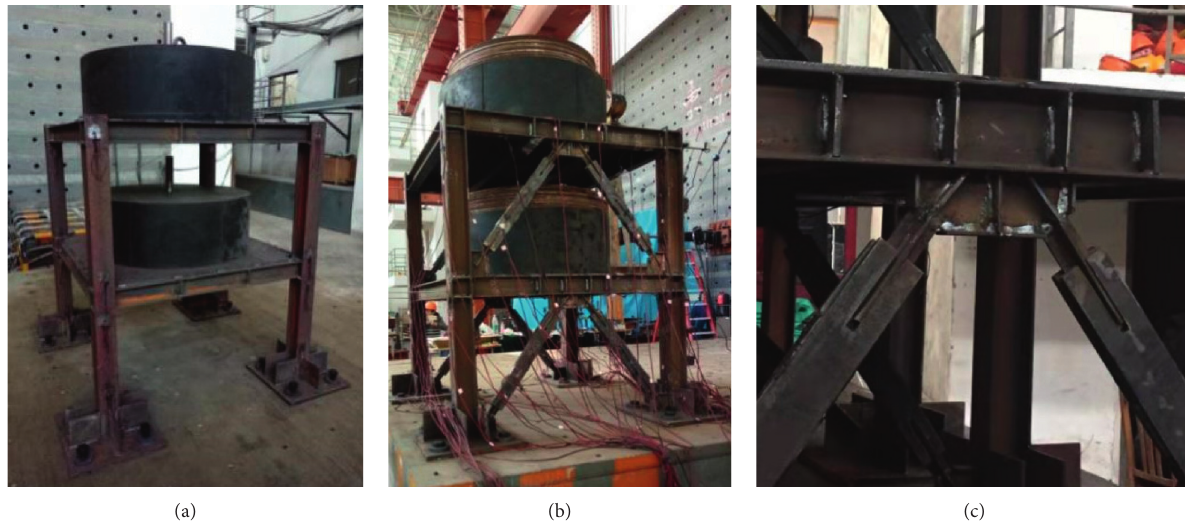
Figure 8: Installed specimen. (a) Pure frame. (b) BRB frame. (c) Enlarged BRB connection.